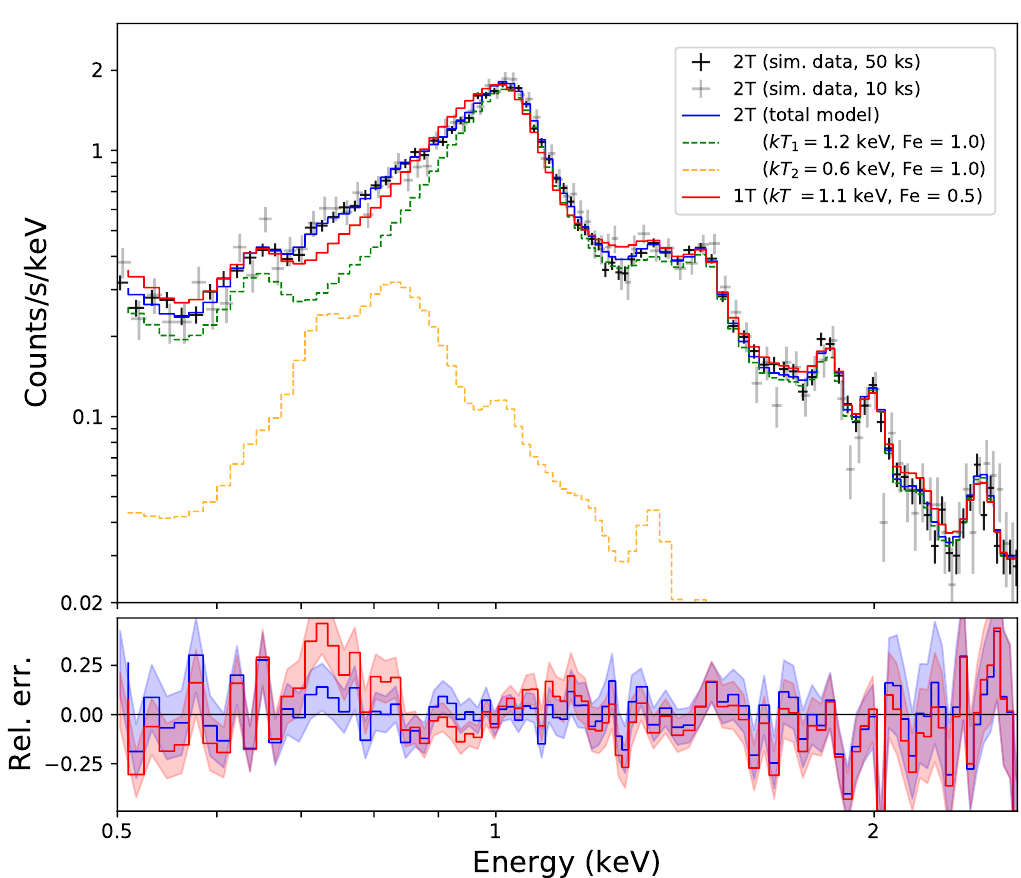
Figure 2. Simulated XMM- Newton MOS observations of a multi-temperature plasma, illustrating the effect of the Fe bias. A mix of 0.6 and 1.2 keV plasmas with emission measures in a proportion of 1:10, Solar abundances in the units of Asplund et al. [43], and a total flux similar to that of NGC5846 (integrated within 0.05r 500 ), was simulated using SPEXACT v3.0.6. Despite the fact that the low temperature component has only 1/10th of the emission measure of the hotter gas, a single temperature fit results in a best fit metallicity that is half of the value input to the simulation. The bottom panel shows the fit residuals for a 1T and 2T model for the 10 ks observation; while there is still a hint that the 1T model does not perfectly describe the data (given the positive residuals around 0.7 keV), this could easily be missed for fainter/more distant targets or when using smaller extraction regions for creating radial profiles or